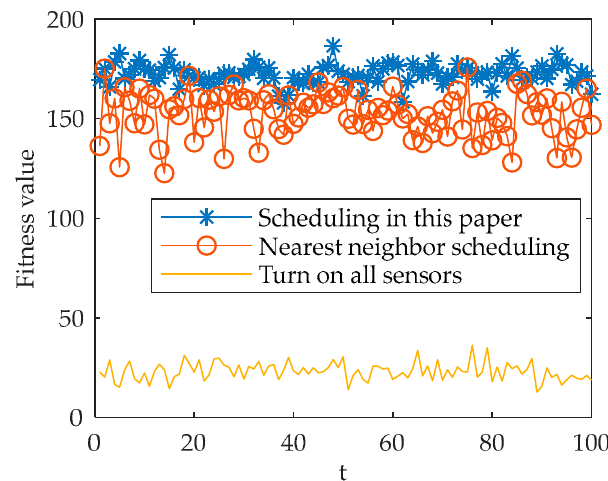
Figure 8. The 25 s and 80 s sensor scheme selection.